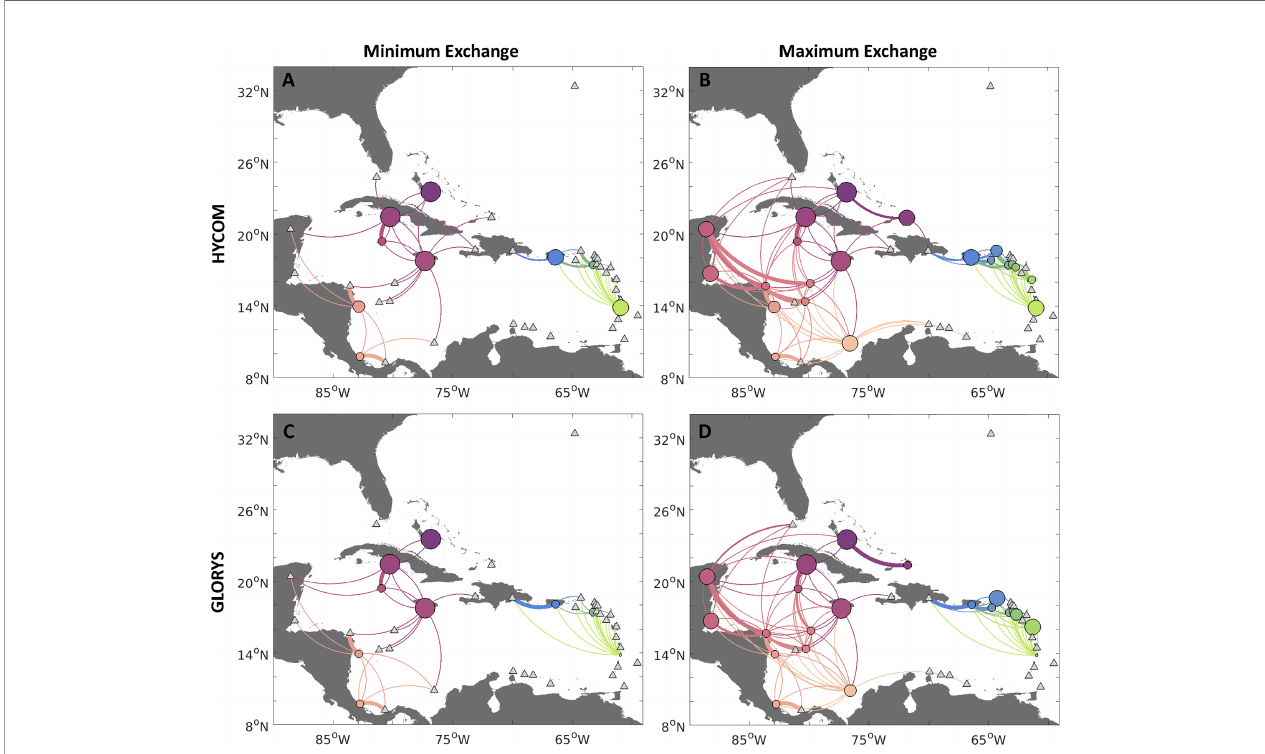
FIGURE 5 | Connectivity network for queen conch considering uncertainty of contemporary (exploited) conch densities, for larvae dispersed with HYCOM ( A, B, top row) and GLORYS12v1 ( C, D, bottom row) velocities. Panels exhibit the minimum ( A, C, left column) and maximum ( B, D, right column) potential connectivity based on possible ranges of adult conch densities (from Horn et al., 2022). Minimum (maximum) potential connectivity is obtained from an uncertainty analysis, where we multiply the probabilistic connectivity matrix of the unexploited release case by 100 spawning distributions drawn from the density curves of adult conch per jurisdiction and use the smallest (biggest) number of larvae exchanged between each spawning-settlement pair to generate the probabilistic connectivity. Edges between nodes represent the strength of connections between sites, whereby the direction of larval fl ow is given by the clockwise direction - concave edges represent export while convex represents import. Node sizes represent the probability of